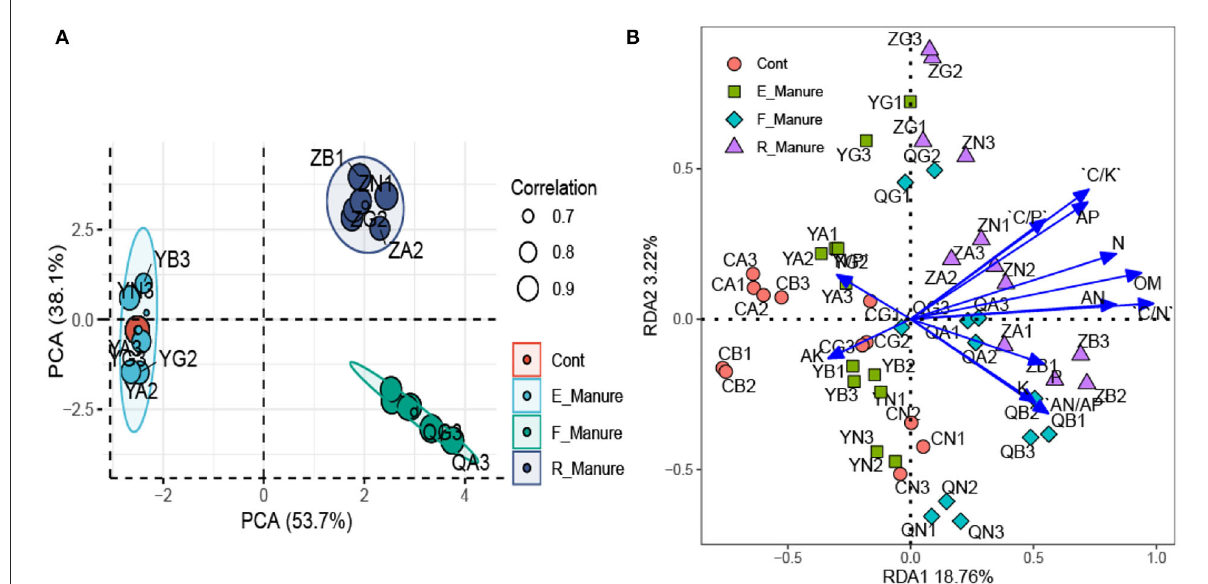
FIGURE3 The chemical properties associated with the treatments of fertilization. Principal component analysis (PCA) of chemical properties using z-transformed variables (A) . Redundancy analysis (RDA) of bacterial communities constrained by the chemical properties (B) . The joint biplot indicates the correlation between the chemical factors and ordination scores of RDA axes. C/N, ratio of carbon and nitrogen; OM, organic